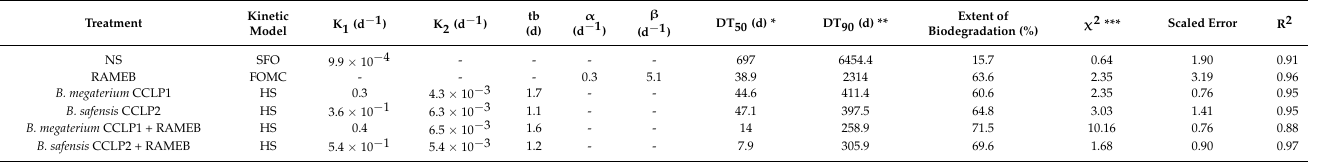
Figure 3. Chlorpyrifos biodegradation curves in ALC soil after the application of: NS ( (cid:7) ), RAMEB + NS ( (cid:78) ), B. megaterium CCLP1 + NS (+), B. safensis CCLP2 + NS (+), B. megaterium CCLP1 + RAMEB + NS (*), B. safensis CCLP2 + RAMEB + NS (*), and control ( • ). Solid lines show model fitting to the experimental results (symbols). Table 4. Kinetic parameters calculated from chlorpyrifos biodegradation curves after different bioremediation treatments were applied on ALC-contaminated